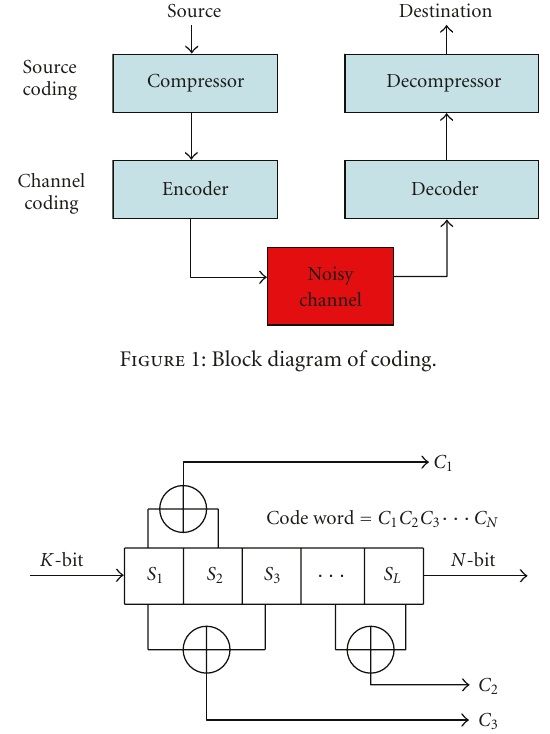
Figure 2: Encoder block (shift register) using convolutional